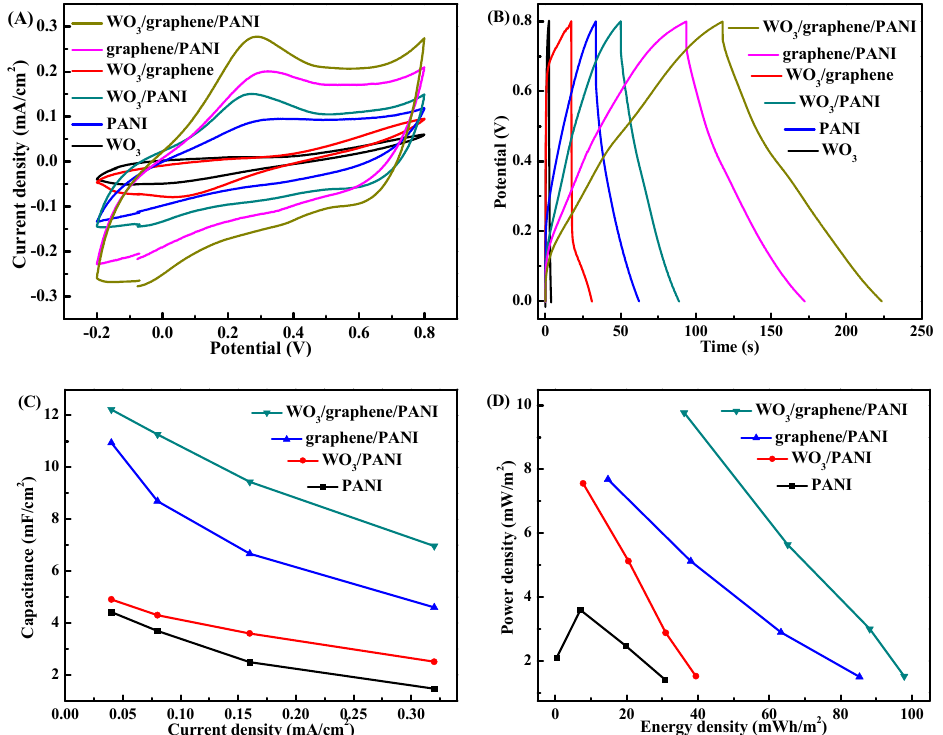
Figure 7. ( A ) CVs conducted at a scan rate of 50 mV/s, ( B ) charge-discharge curves with a current density of 0.08 mA/cm 2 , ( C ) specific capacitances depended on current density, and ( D ) Ragone plots of bare WO 3 film, double layer WO 3 /graphene film, pristine PANI film, double layer WO 3 /PANI film, double layer graphene/PANI film, and triple layer WO 3 /graphene/PANI film measured in 0.5 M H 2 SO 4 aqueous solution.